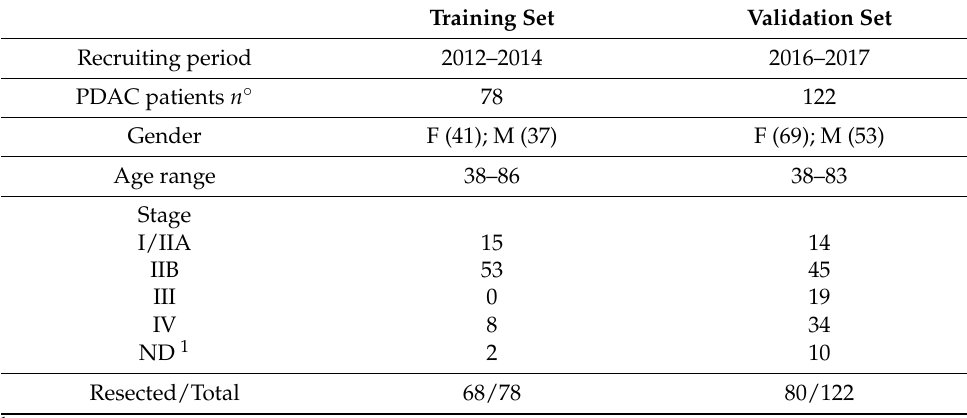
Table 1. Clinical characteristics of the study population of PDAC patients. Training Set Validation